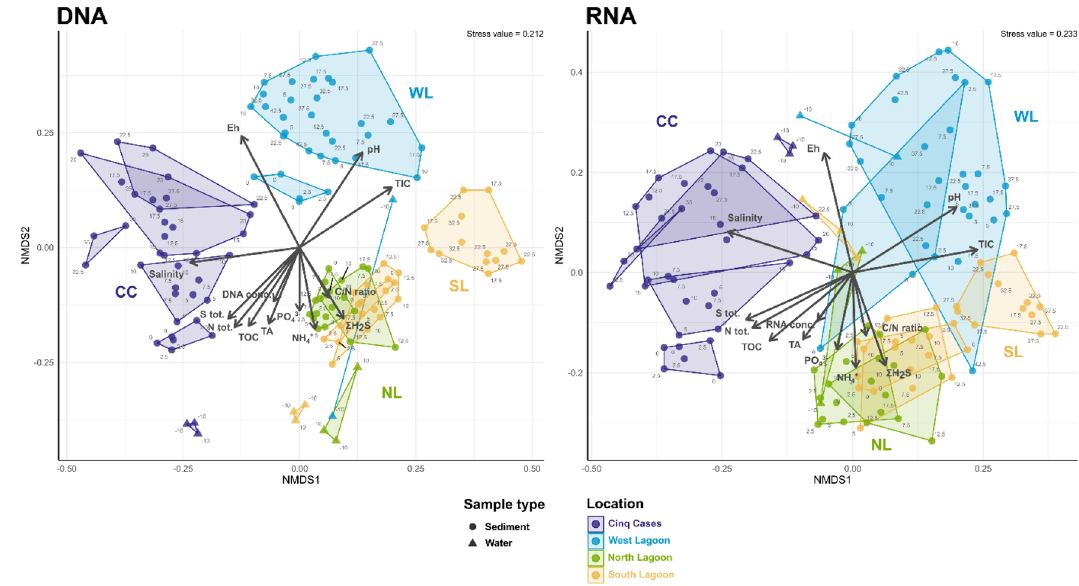
Figure 4. Non-metric multidimensional scaling of total and active bacterial community composition, geochemical zonation and significantly correlated environmental factors. NMDS based on a Bray–Curtis distance matrix of all DNA- and RNA-based sediment and water samples. The ASV table was normalized using GMPR 80 , and technical and biological replicates were averaged. Outlines indicate the geochemical zonation. Environmental fit was plotted if P ≤ 0.05 (Supplementary Table S2) using R 2 as arrow